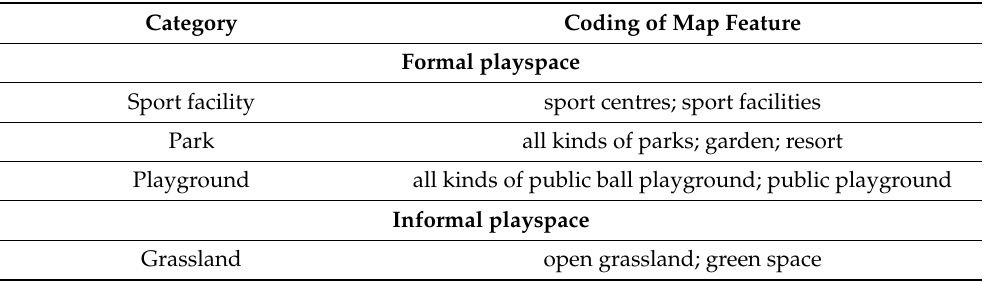
Table 2. Map feature and coding of potential formal and informal playspaces.